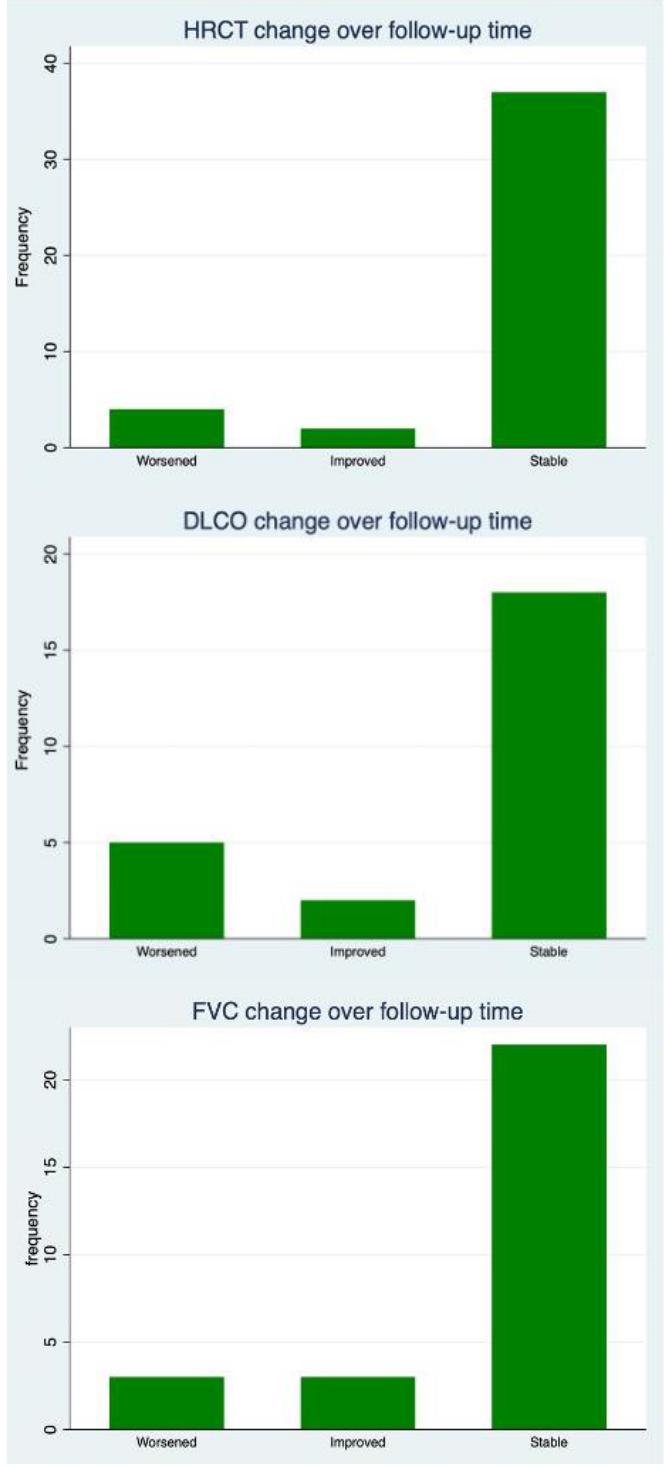
Figure 1. Pulmonary function tests and high-resolution computed tomography (HRCT) evolution. Upper Panel: ILD evolution at HRCT, Middle Panel: diffusing capacity of lung for carbon monoxide (DLCO). Lower Panel: forced vital capacity (FVC).